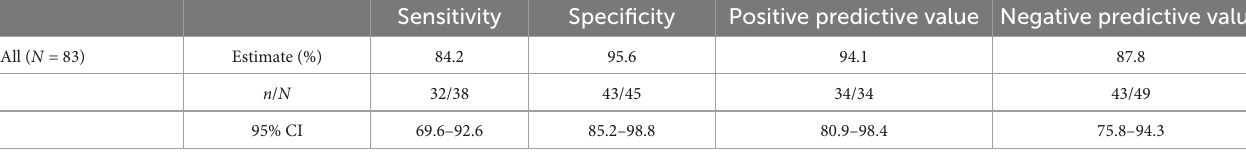
TABLE 5 Performance of OVAWatch in a high-prevalence independent data